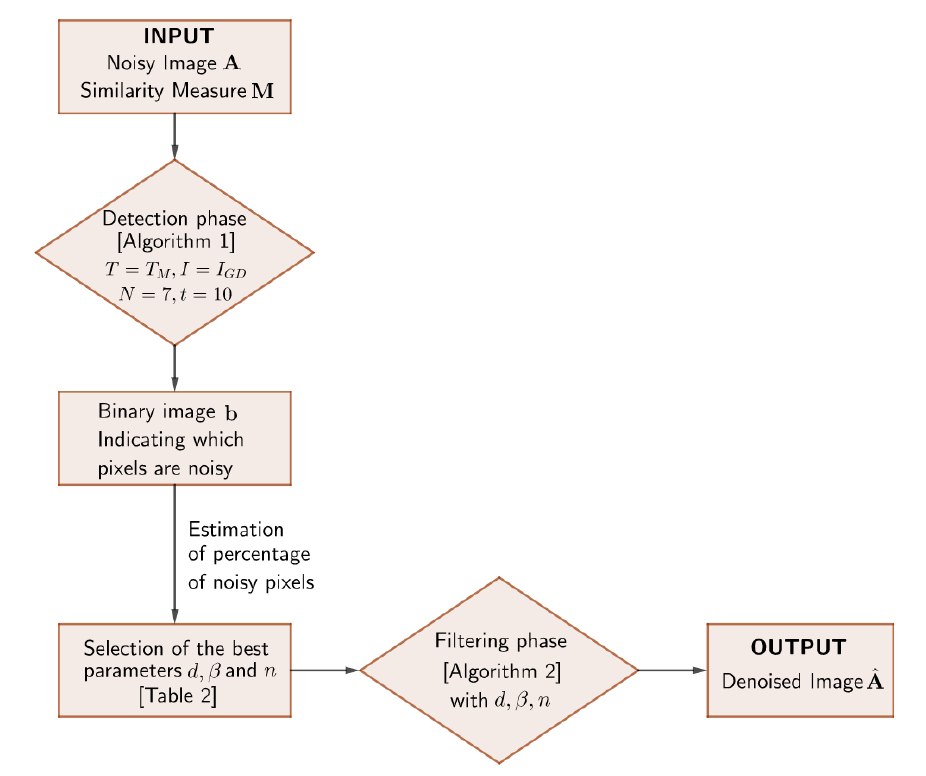
Figure 4. Flow chart of the AWAM filter with the recommended parameter